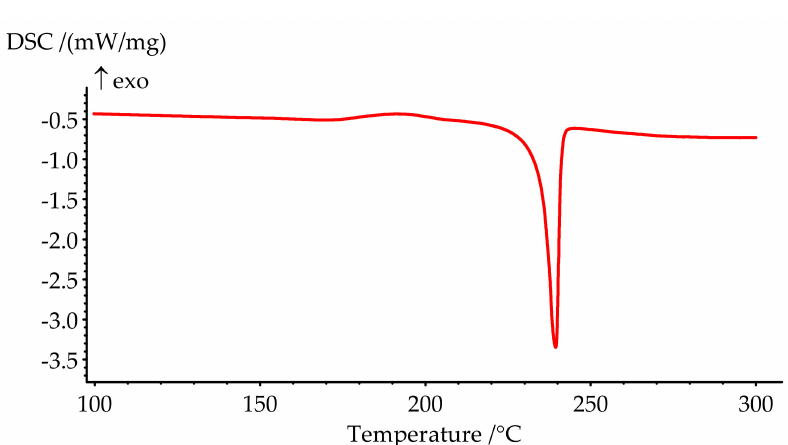
Figure 4. NMR 13 C spectrum of PN-mt.